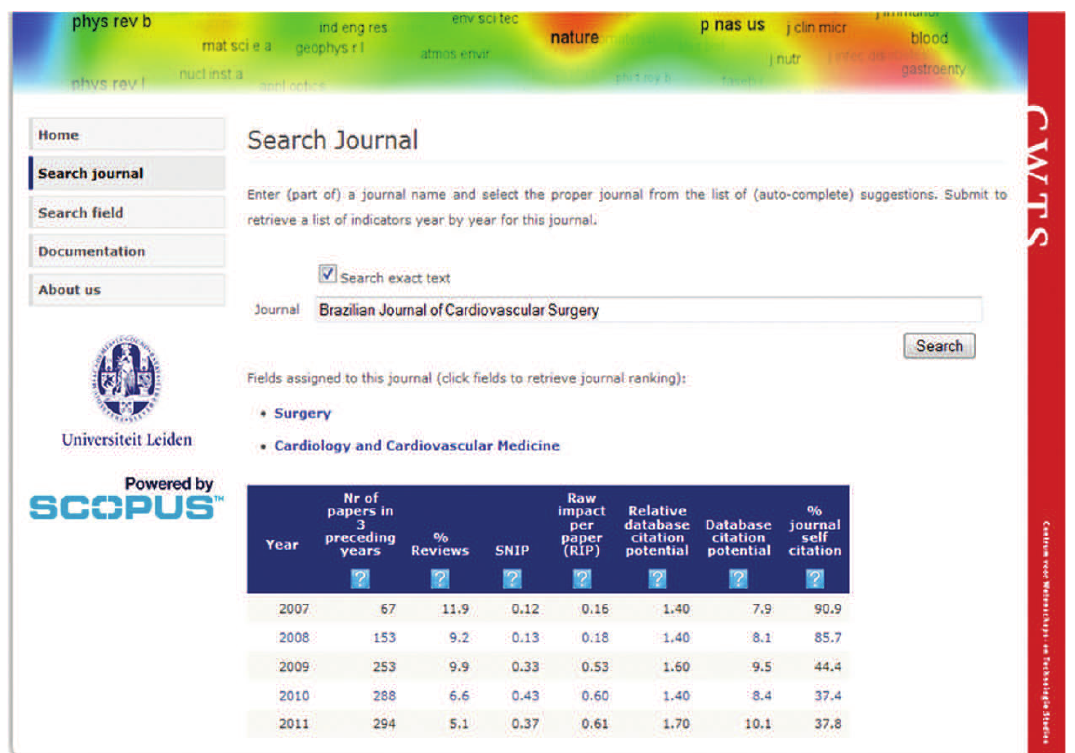
Fig. 1 - Índices da RBCCV/BJCVS no elative Database Citation Potential , da